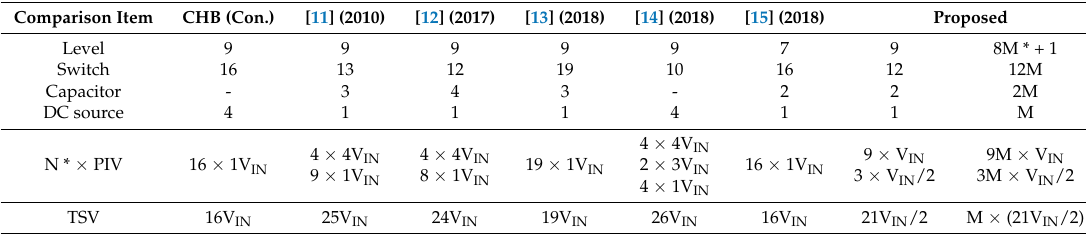
Table 1. Comparison of the proposed topology with other recently presented inverters.